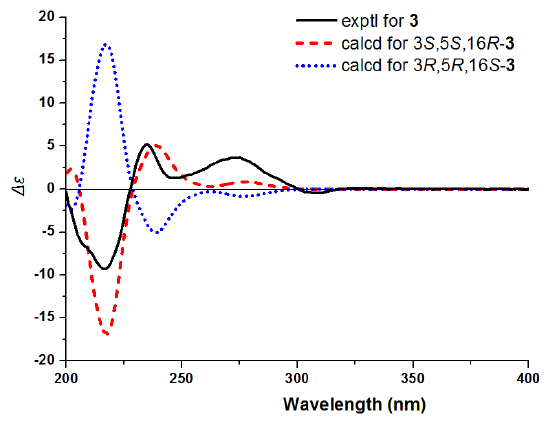
Figure 8. Experimental and calculated ECD spectra of 3 .